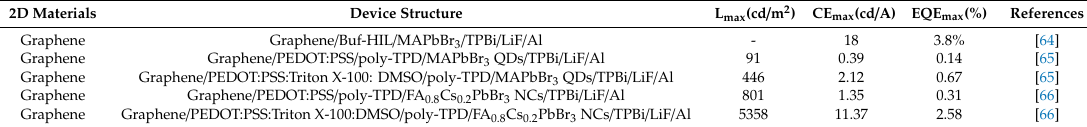
Figure 8. Schematic structures of perovskite light emitting diodes (PeLEDs), in which perovskite materials as EML and 2D materials as ( a ) HTL, ( b ) HIL, ( c ) dopant in HTL. Table 4. Summary of the device parameters of PeLEDs incorporating 2D materials.